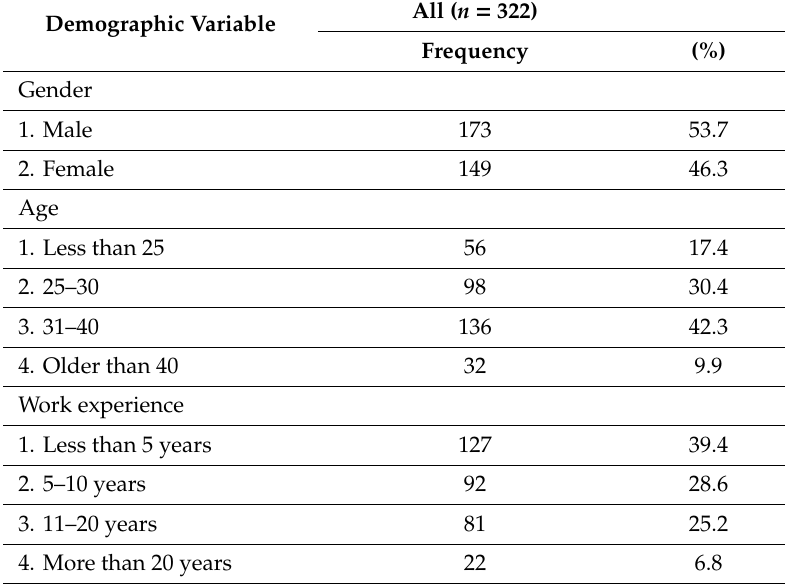
Table 1. Profile of